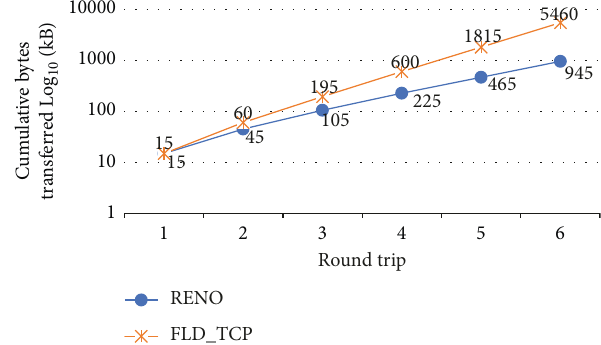
Figure 1: Cumulative bytes transferred per round trip.